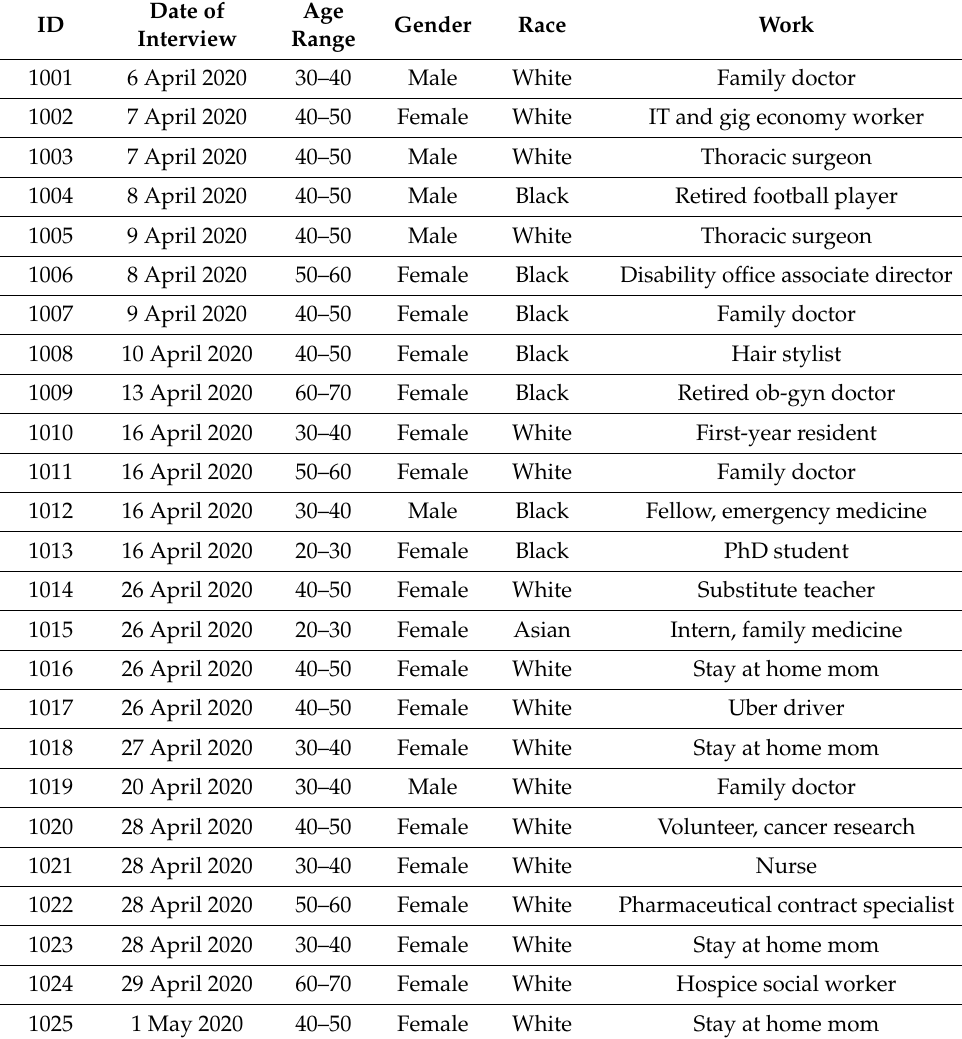
Table 1. Participants’